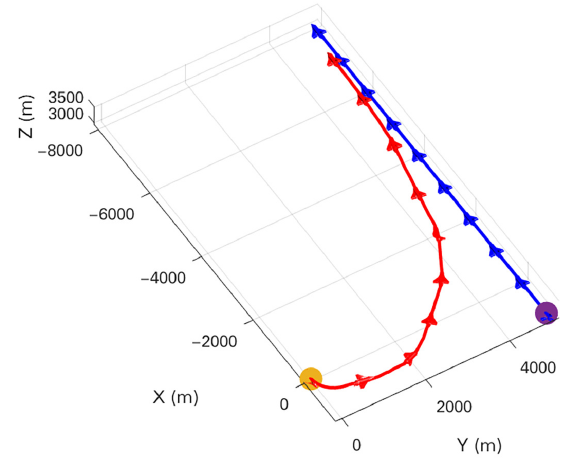
Figure 9. The two UCAV tracks in the middle training period in case 1.